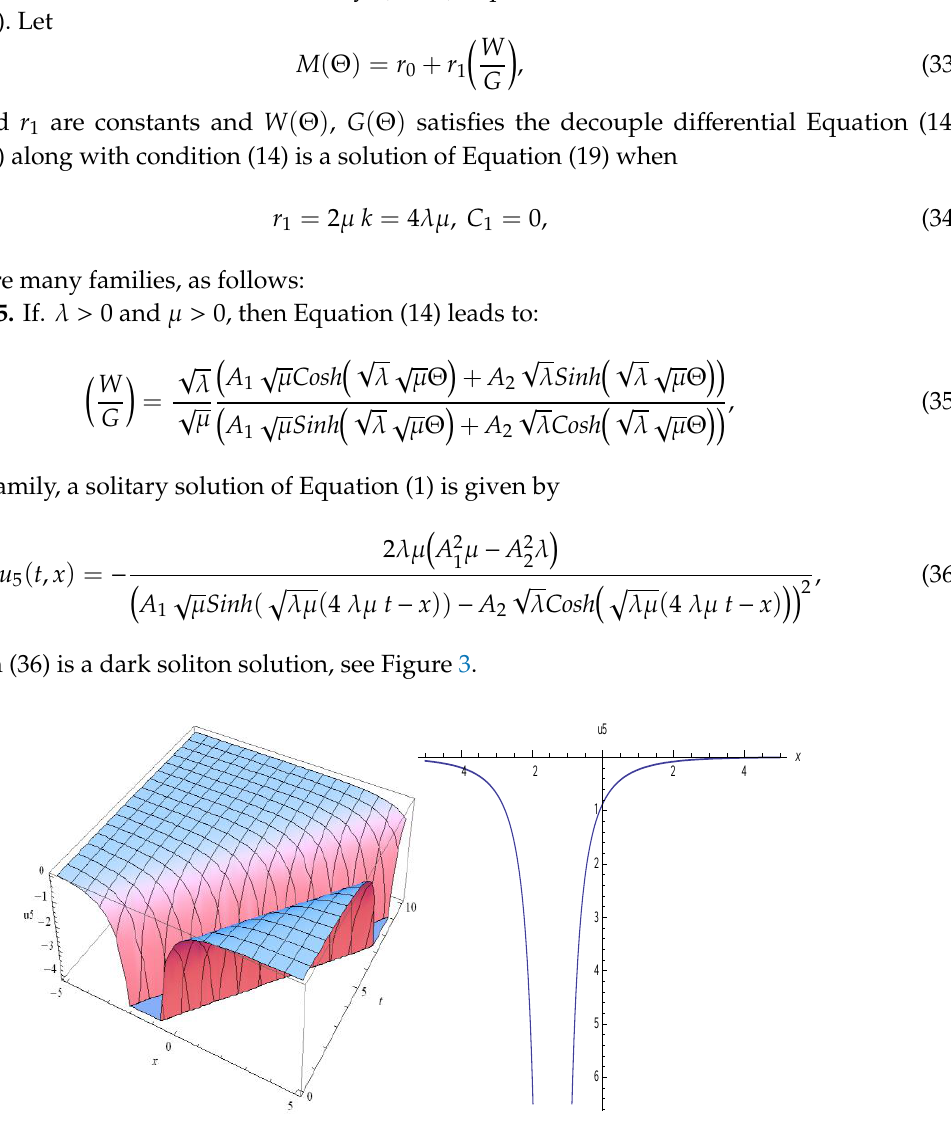
Figure 2. The bright soliton solution (32) of Equation (1) and its projection at t = 0 when A = 1, C = 1, B = 4.